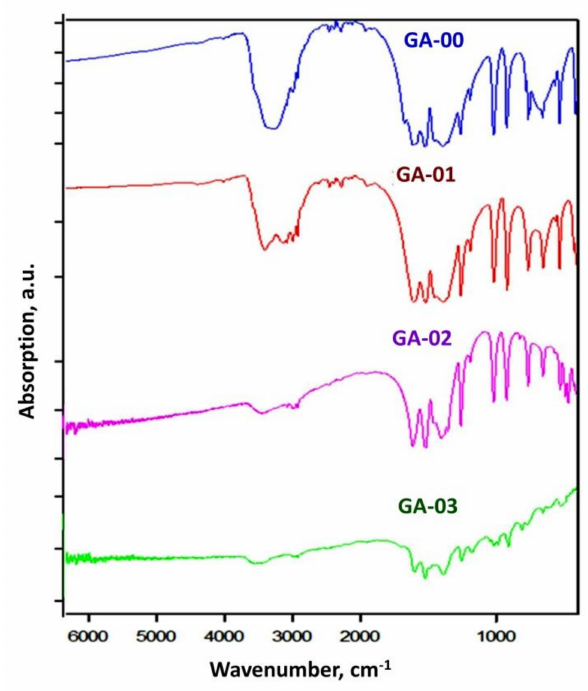
Figure 7. IR absorption spectra of Gd(acac) 3 preparations after stepwise annealing (ID samples see in Table